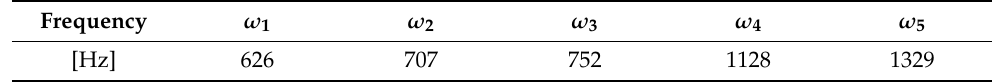
Figure 4. The absorbtion of the flywheel 5.